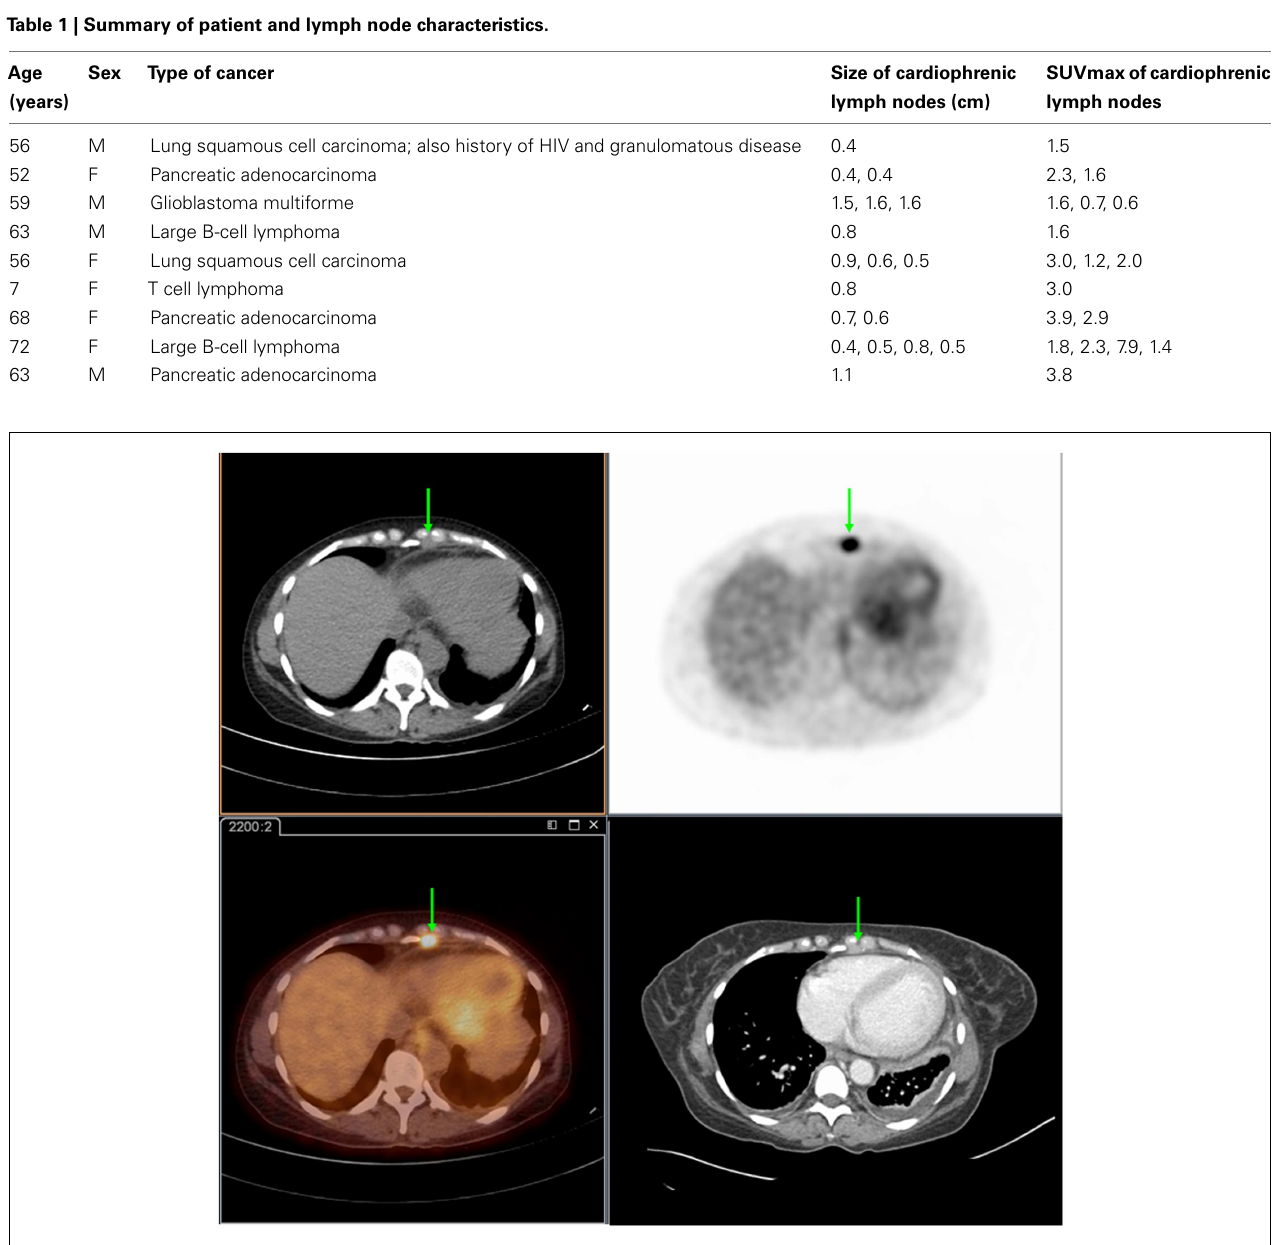
fused images (bottom left).These were not commented on in the contrast-enhanced CT (bottom right). Differences in the levels between the two studies are due to patient positioning and respiratory